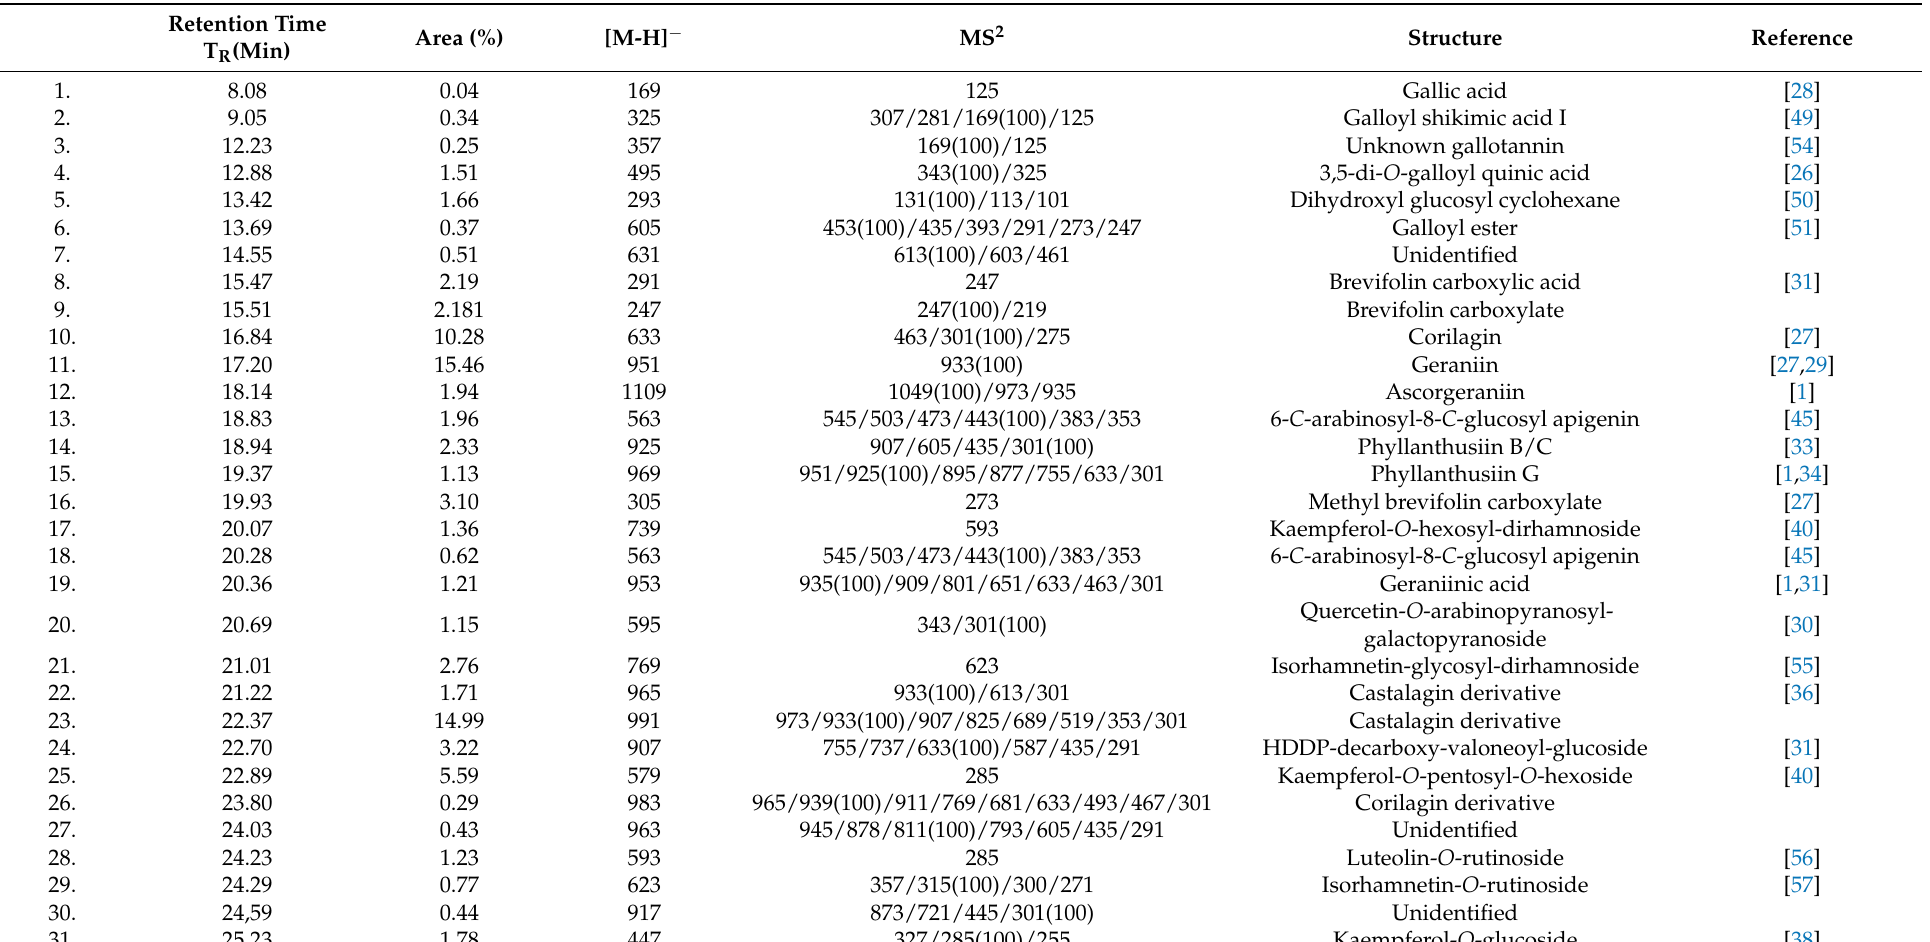
Table 8. Identification of compounds from Erodium arborescens acetone extract by LC-HESI-MS 2 (negative mode). The relative peak area indicates the contribution of each compound to all identified compounds in the extract, providing a measure of relative